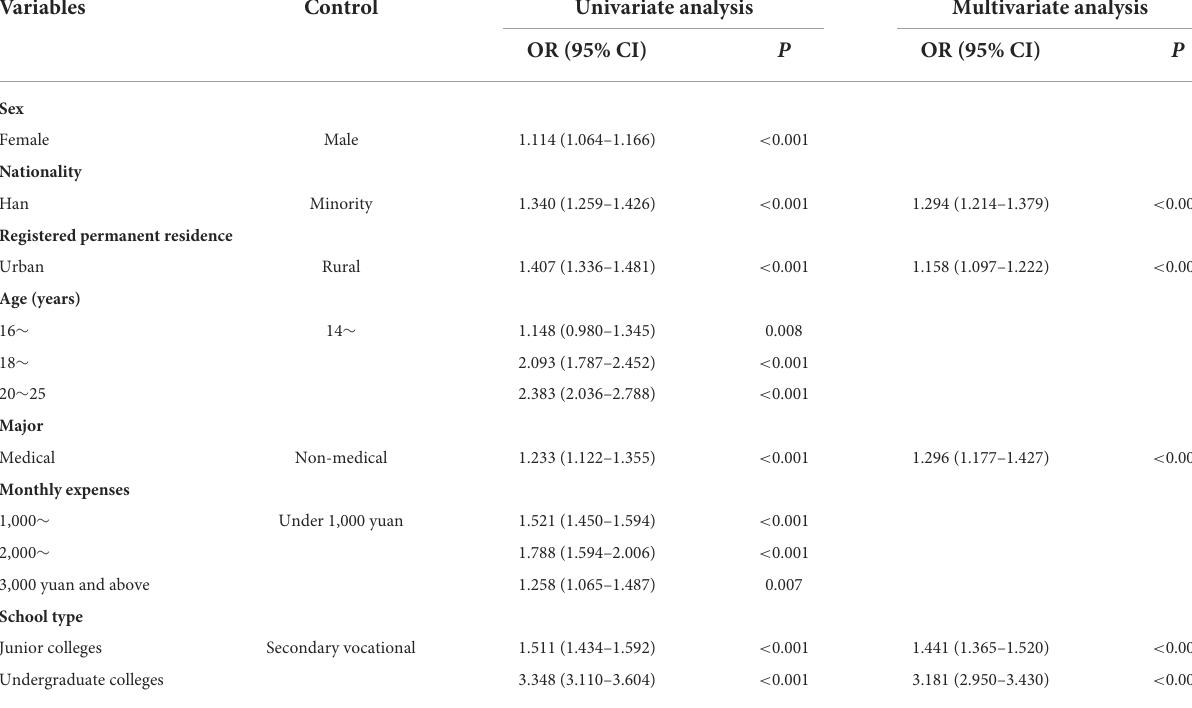
TABLE 5 Logistic regression analysis of HIV/AIDS knowledge among young students ( n =